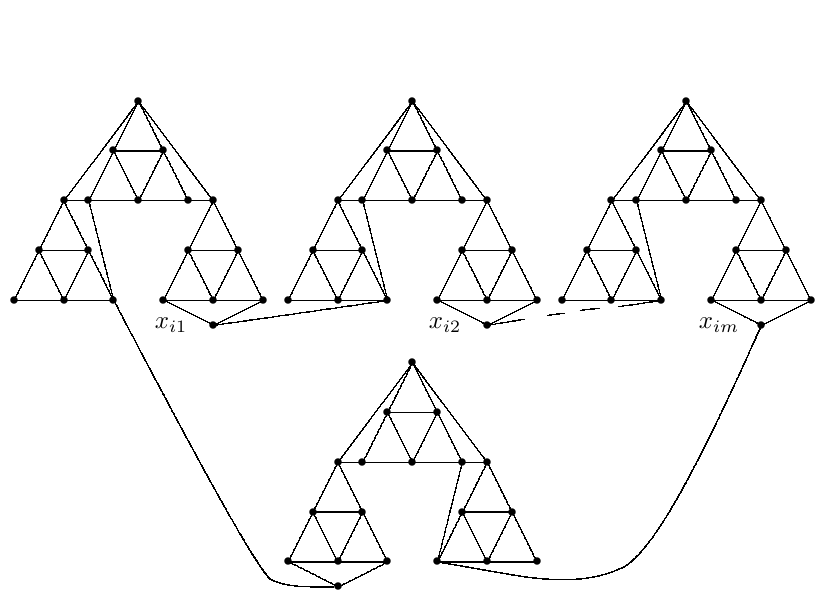
Fig. 9: The graph F